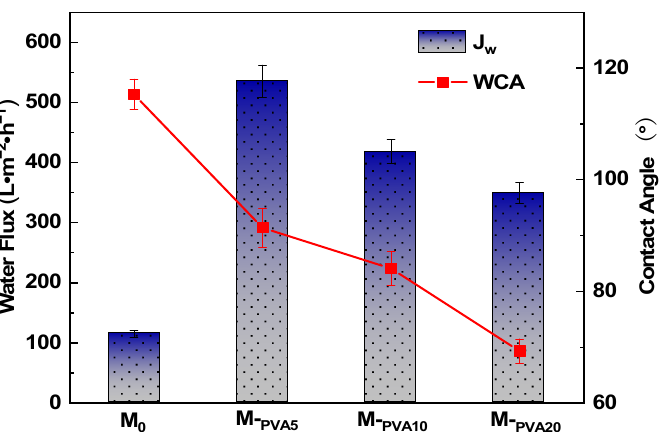
Figure 7. Water flux and water contact angle of PTFE microfiltration membranes coated with different concentrations of PVA solution.